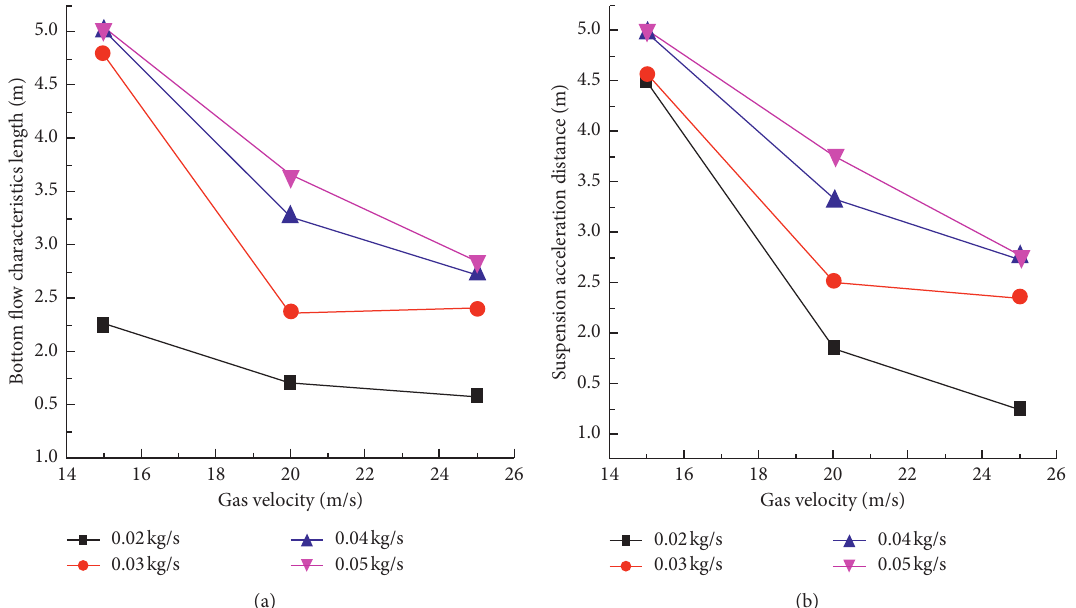
Figure 17: The characteristic length of bottom flow and the suspension acceleration